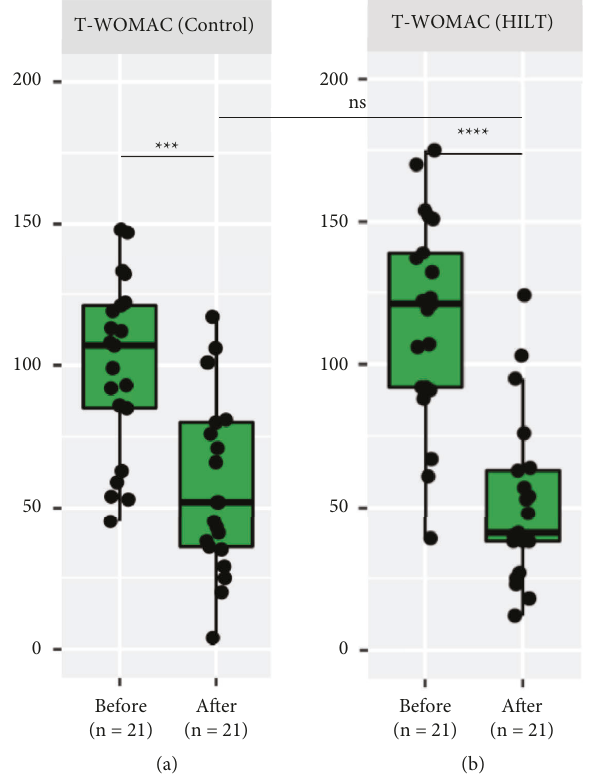
Figure 3: Box plot showing overall analysis of changes in the T- WOMAC scores within the same group and compared between the groups. (a). Change in the T-WOMAC score in the control group compared before and after treatment completion. (b). Change in the T-WOMAC score in the HILTgroup compared before and after treatment completion. Data are shown as ns (not significant) � p value > 0.05, ∗ � p value < 0.05, ∗∗ � p value < 0.01, ∗∗∗ � p value < 0.001, and ∗∗∗∗ � p value < 0.0001. HILT, high-intensity laser therapy; T-WOMAC, the modified Thai version of Western Ontario and McMaster Universities Osteoarthritis